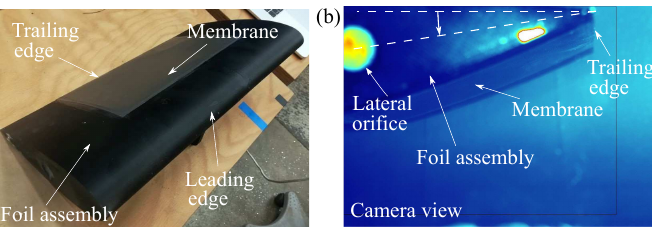
Figure 5. ( a ) Final assembly of blade showing the membrane at the suction side of the blade and ( b ) side view from the blade with the membrane at an angle of attack of 10 ◦ in the water